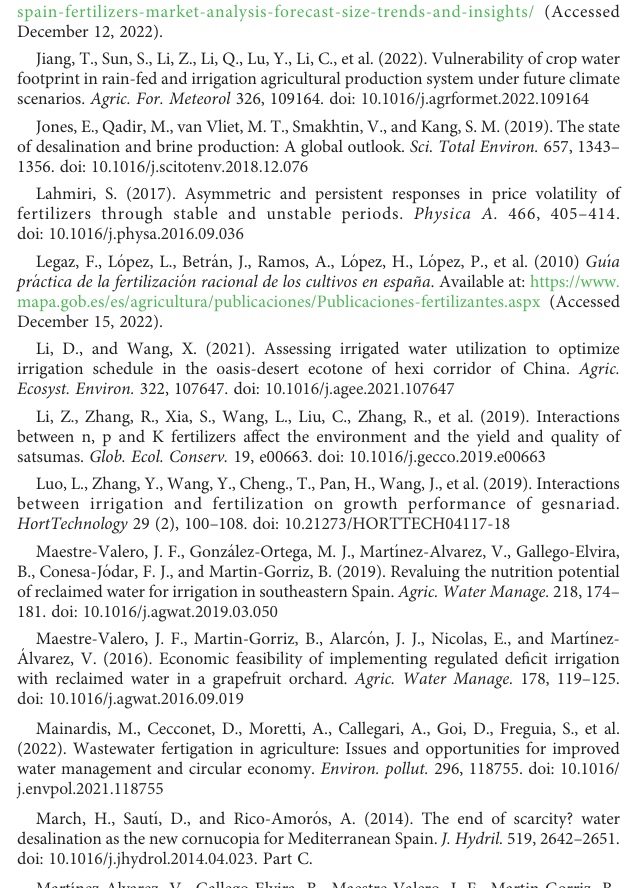
SUPPLEMENTARY FIGURE 3 Crop nutritional